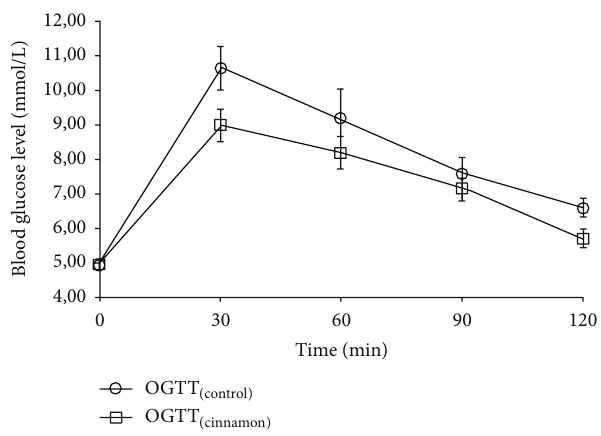
Figure 1: Mean ( ± SEM) time course of blood glucose levels (mmol/L) in nondiabetic subjects after OGTT ( control ) ( I ) and OGTT ( cinnamon ) ( ◻